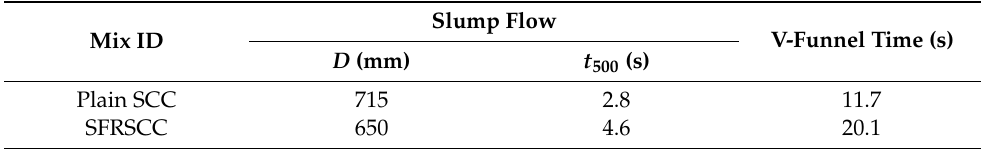
Table 2. Fresh properties for plain SCC and SFRSCC.